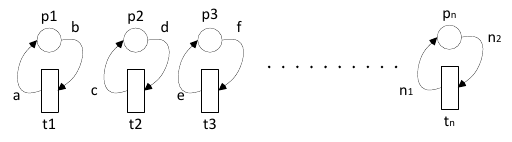
Fig. 3. Separate Petri nets with square matrices